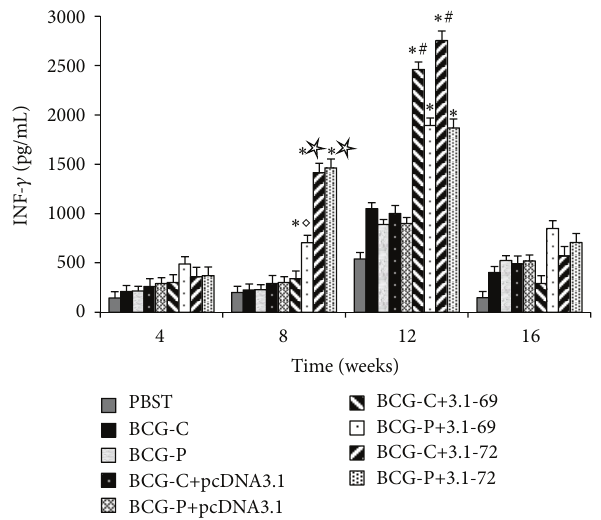
Figure 4: Analysis of IFN- 𝛾 released from splenocytes. After animals were harvested; splenocytes were collected and prepared as described in Section 2. IFN- 𝛾 concentration in the medium was measured by ELISA kit according to the manufacturer’s protocol. Triplicatetestsweredoneforeachmediumsample. ∗ 𝑃 < 0.01 versus PBST, BCG-C, BCG-P, BCG-C+pcDNA3.1, or BCG-P+pcDNA3.1 groups. # 𝑃 < 0.05 versus BCG-P+3.1-69 or BCG-P+3.1-72 group. ◊ 𝑃 < 0.05 versus BCG-C+3.1-69 group. f 𝑃 < 0.05 versus BCG- C+3.1-69 or BCG-P+3.1-69